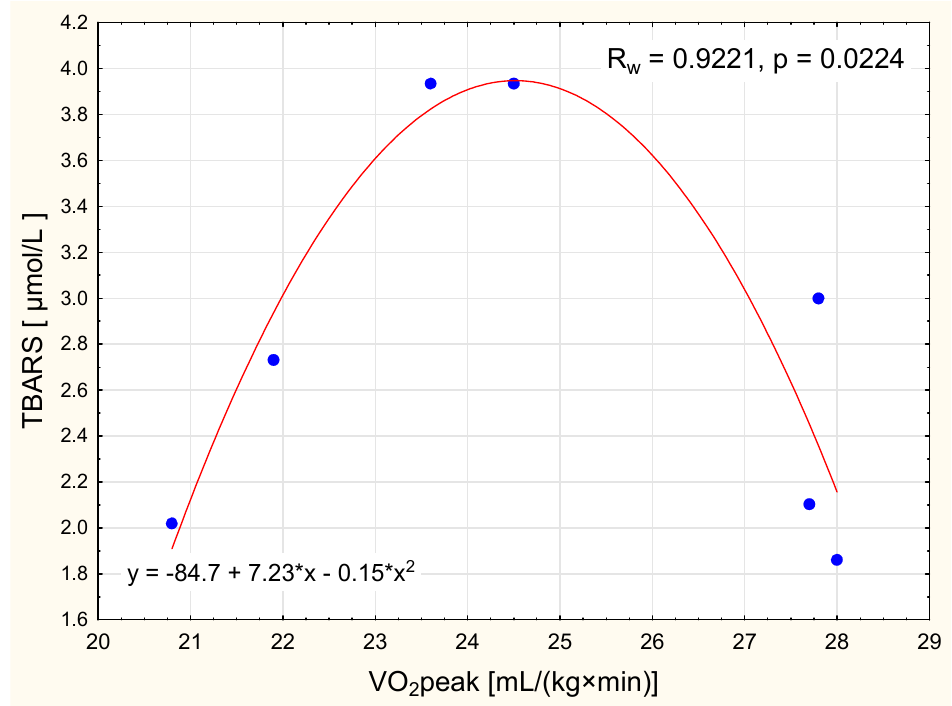
Figure 2. The relationship between VO 2 peak and level of thiobarbituric acid reactive substances (TBARS) in normal weight women after the intervention (nonlinear squared correlation).